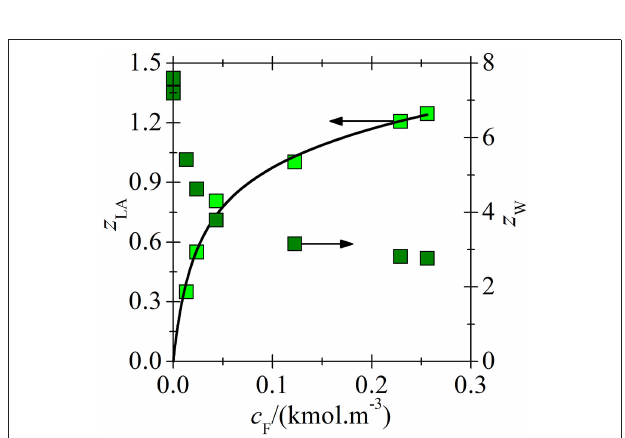
according to the model based on experimental data in paper ( Marták and Schlosser, 2007). For z W. coext see Equation (9).